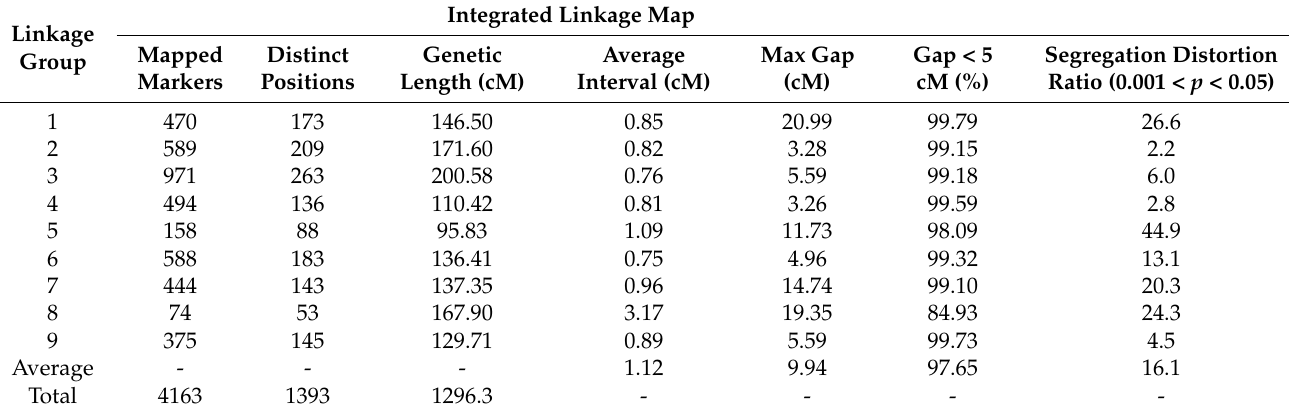
Table 3. Summary of the integrated linkage map of